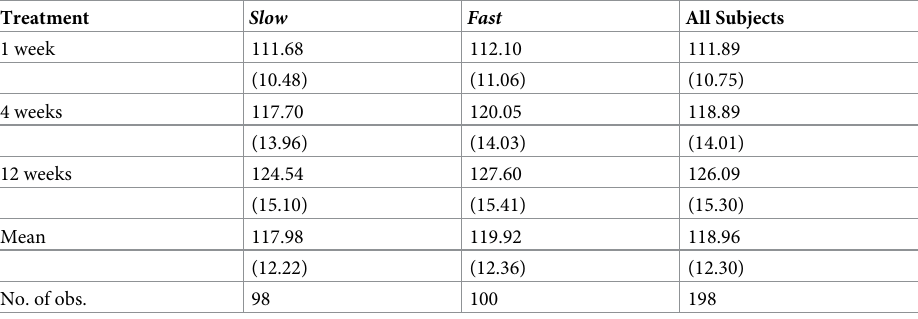
Table 2. Comparison of switch points by treatment.